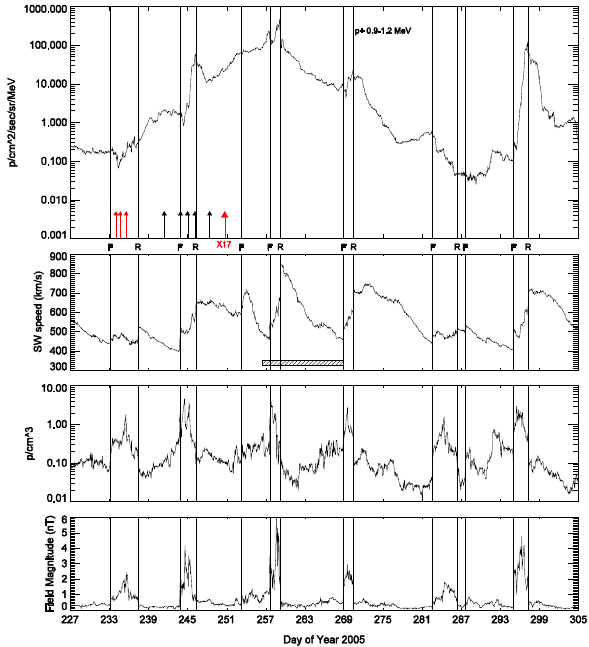
Fig. 1. Overview of the 0.9–1.2MeV energetic proton intensities as measured by the Ulysses COSPIN/LET instrument, solar wind velocity, plasma ion density and IMF magnitude from 15 August till the end of October 2005 (DOY 227–305). The hatched horizontal bar in the second panel denotes a period with ICME characteristics. Upward pointing red and black vertical arrows indicate solar events that occurred during this period (see Table 1).